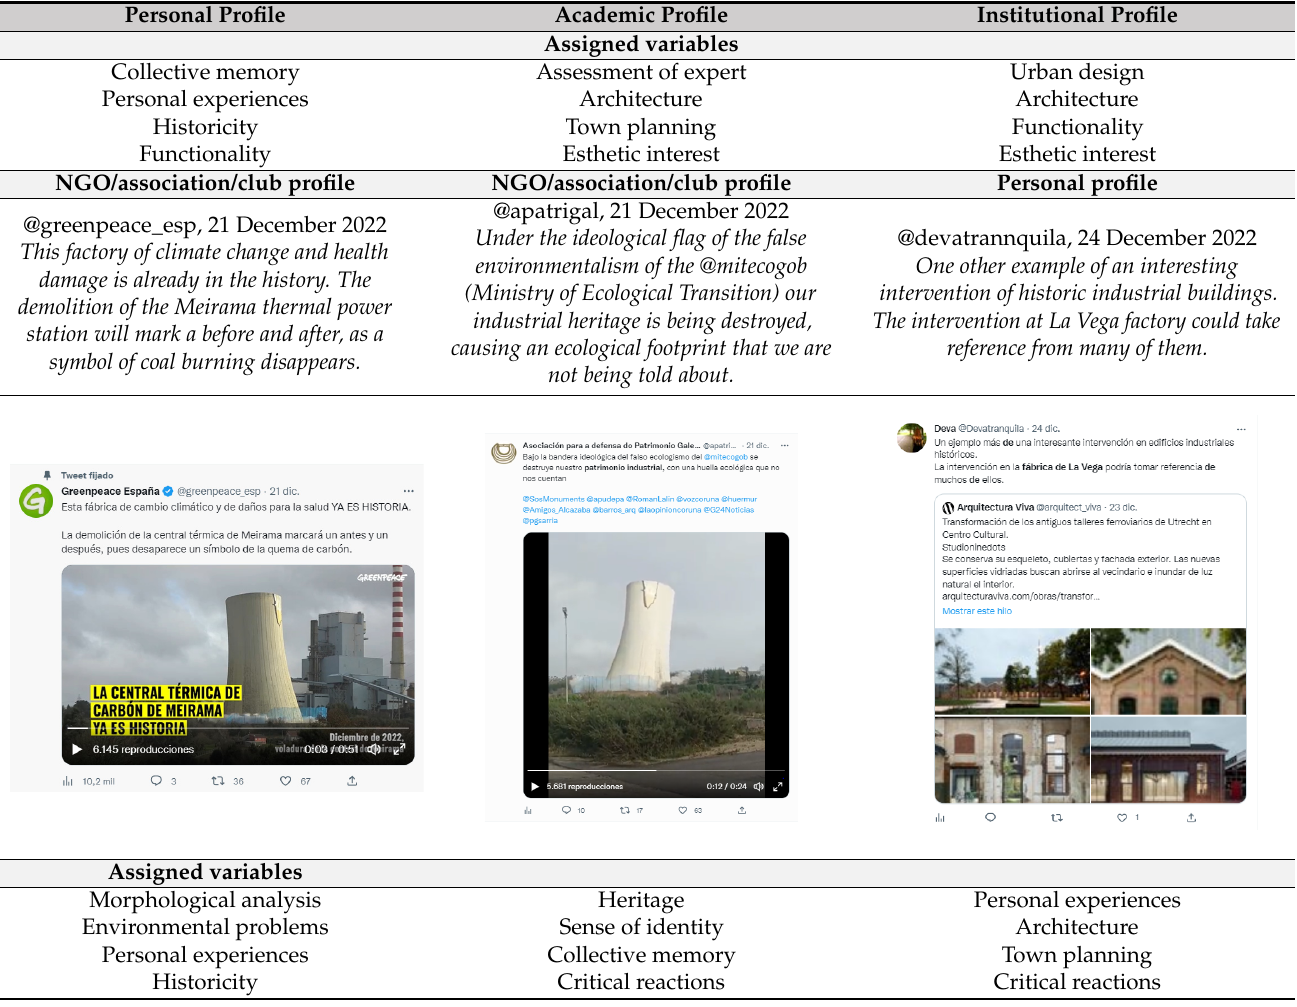
Table 6. Results of sampling #2.